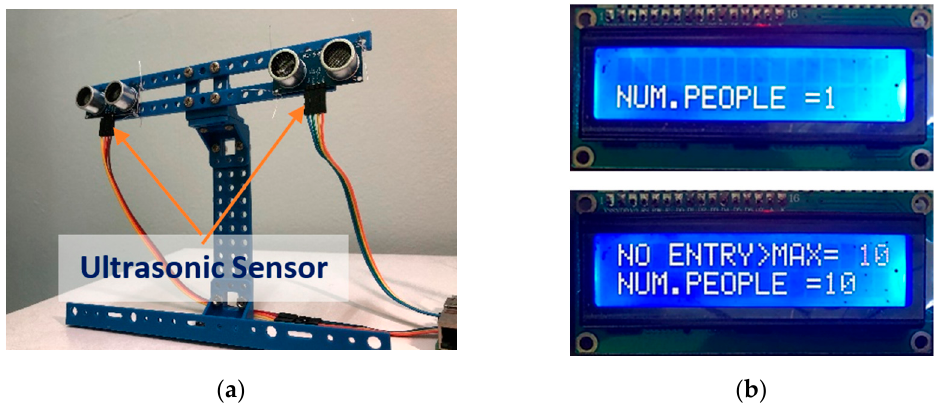
Figure 12. ( a ) Person counter prototype and ( b ) LCD indicates the number of people equal to 1 and the no entry indication if there are more than 10 individuals.